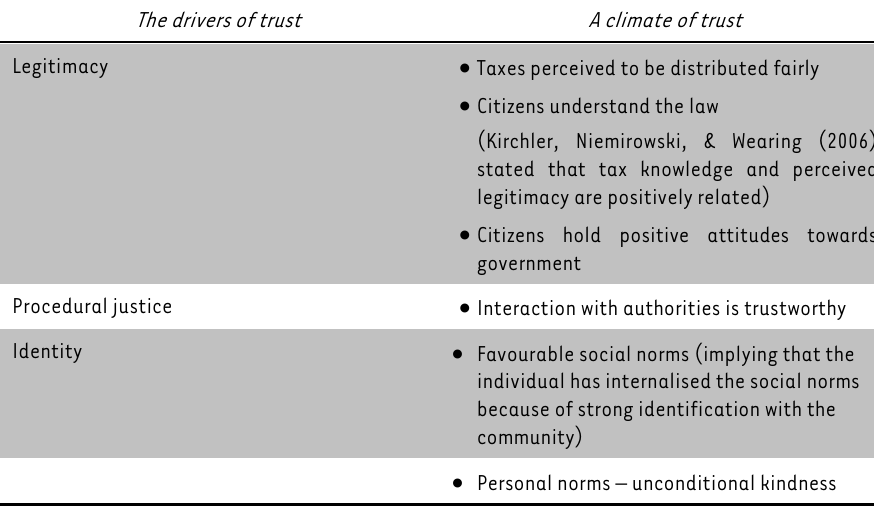
The comparison of the drivers of trust and a climate of trust The drivers of